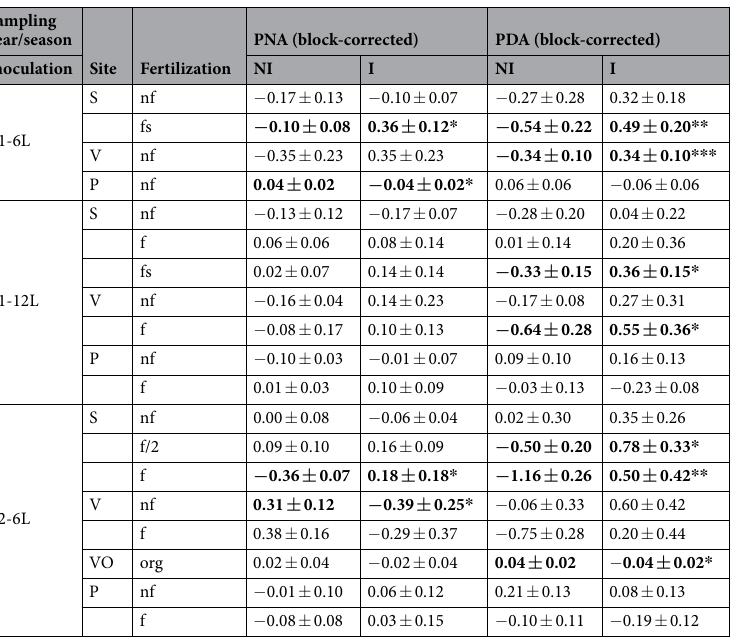
Table 2. Effects of maize inoculation by Azospirillum lipoferum CRT1 on potential nitrification activity, PNA, and potential denitrification activity, PDA, at 6-leaves stage, year 1 (Y1-6L), 12-leaves stage, year 1 (Y1-12L), and 6-leaves stage, year 2 (Y2-6L). Values are corrected for block effects. Means ± standard errors (n = 5) are presented. S, V and P refer to the Slope, Valley and Plateau sites, respectively. nf, f, fs and f/2 refer to not fertilized, fertilized, fertilized at sowing, and reduced fertilization, respectively. VO-org refers to Valley site organically